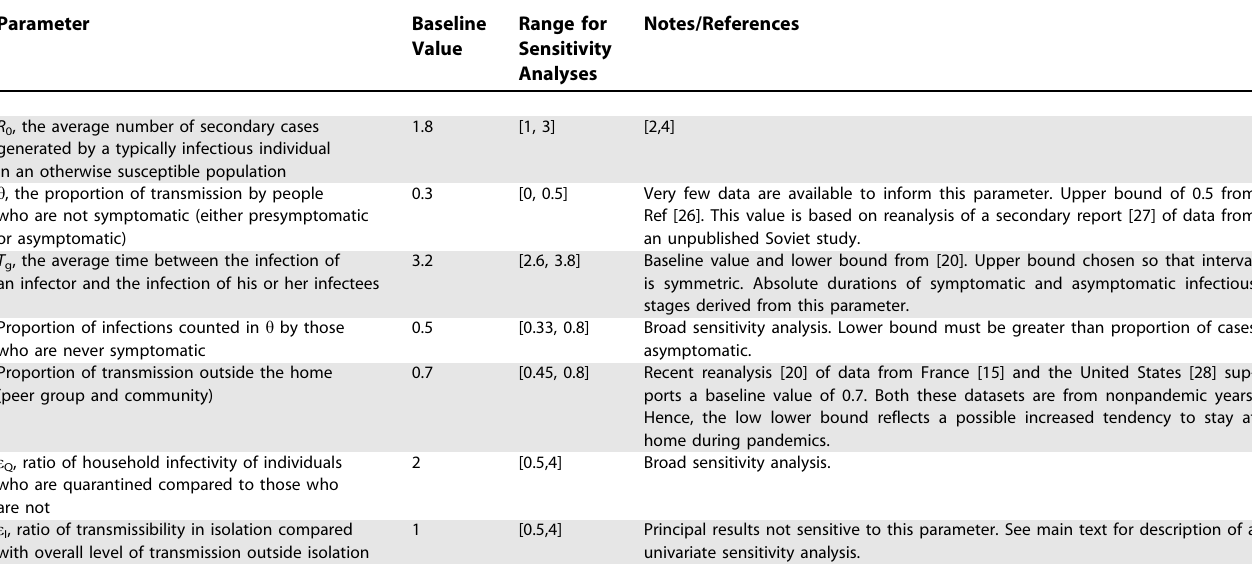
Table 1. Assumptions for Key Unknown Transmission Parameters